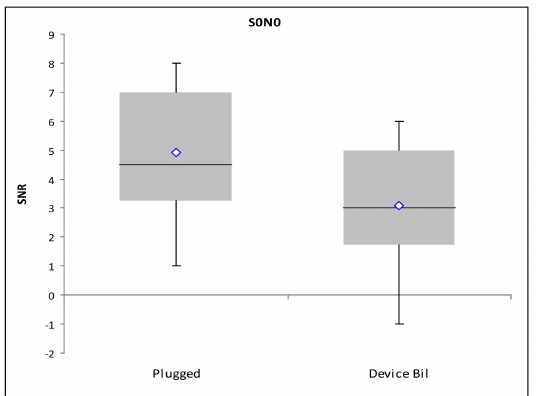
Figure 4. Loudness summation SRT 50 for the unaided and bilaterally aided plugged